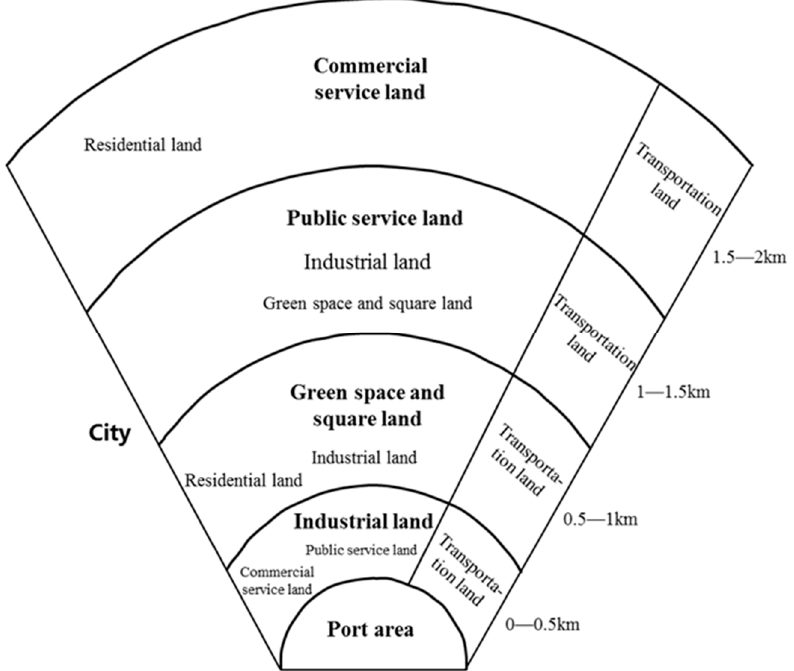
Figure 13. The urban regional structure model diagram of the coastal port–city interface (source: drawn by author). drawn by